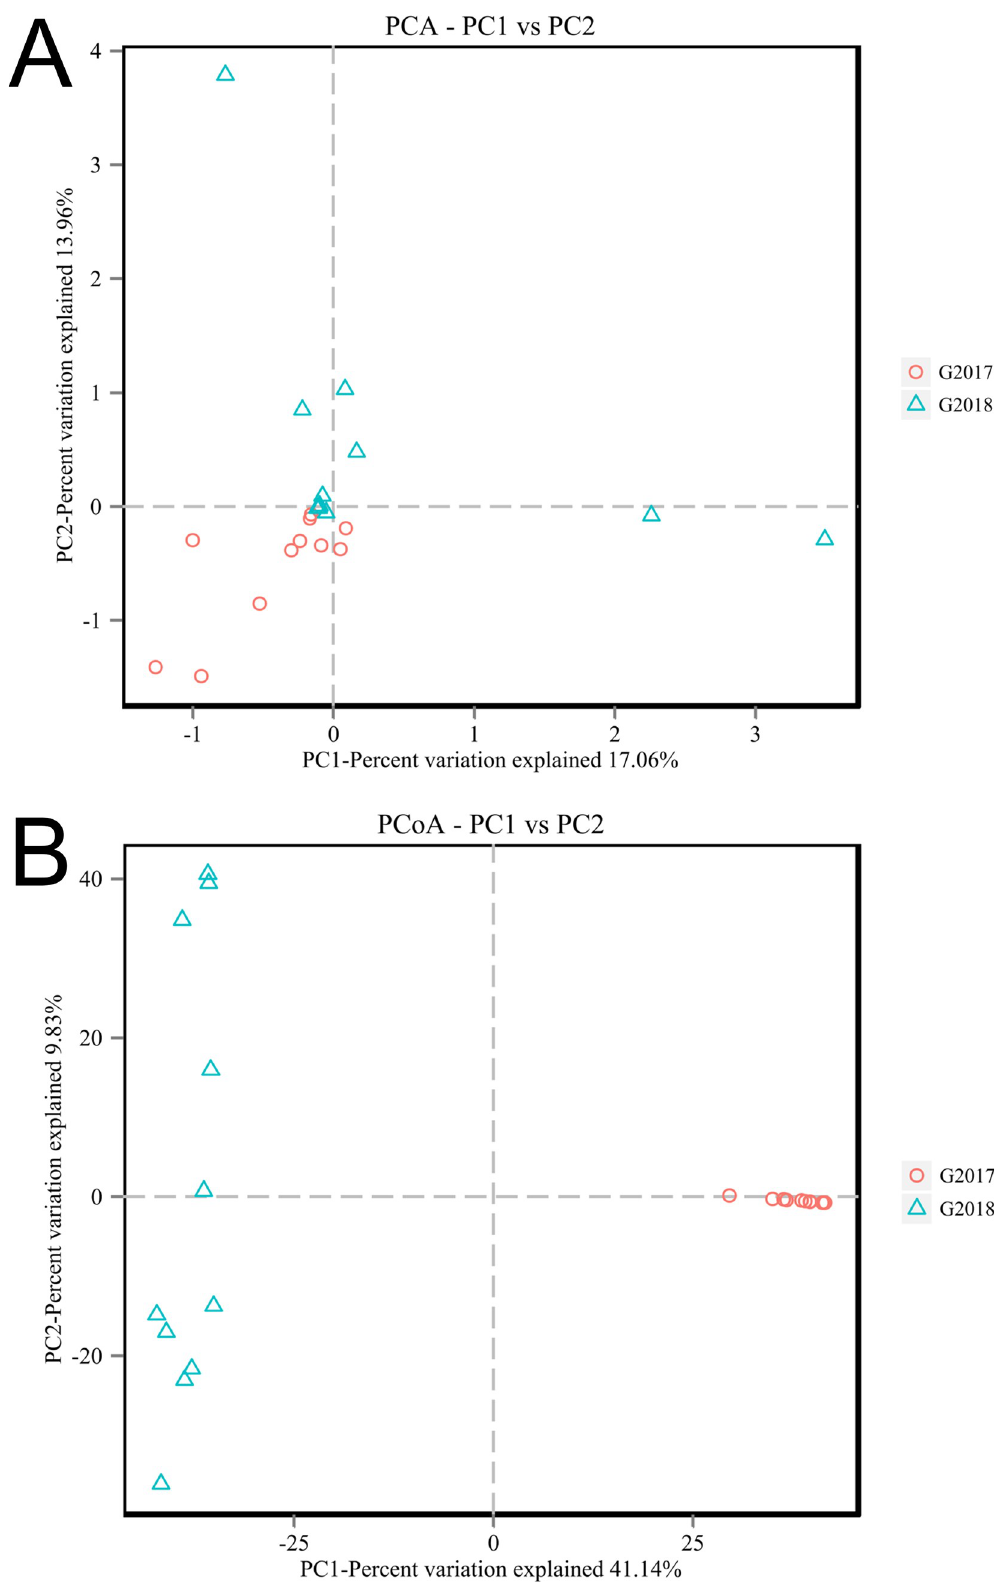
Fig 5. Principal component analyses of the bacterial (A) and fungal (B) communities in all 22 samples in 2017 and 2018. https://doi.org/10.1371/journal.pone.0236165.g005 PLOS ONE | https://doi.org/10.1371/journal.pone.0236165 July 22,